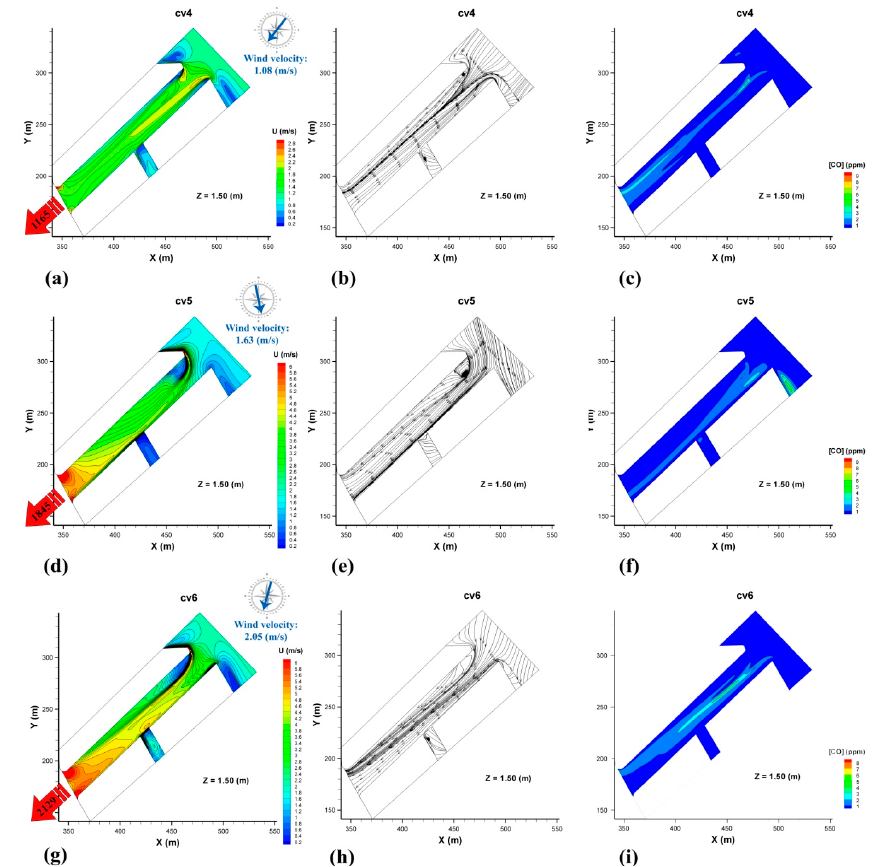
Figure 6. Contour velocity planes ( a , d , g ), streamlines ( b , e , h ), and contour planes of CO concentration ( c , f , i ) for cv4, cv5, and cv6 validation cases, respectively. The planes were located at 1.5 m of height. Traffic and wind direction are marked with red and blue arrows, respectively. Traffic intensity and velocity are specified in their respective arrows.